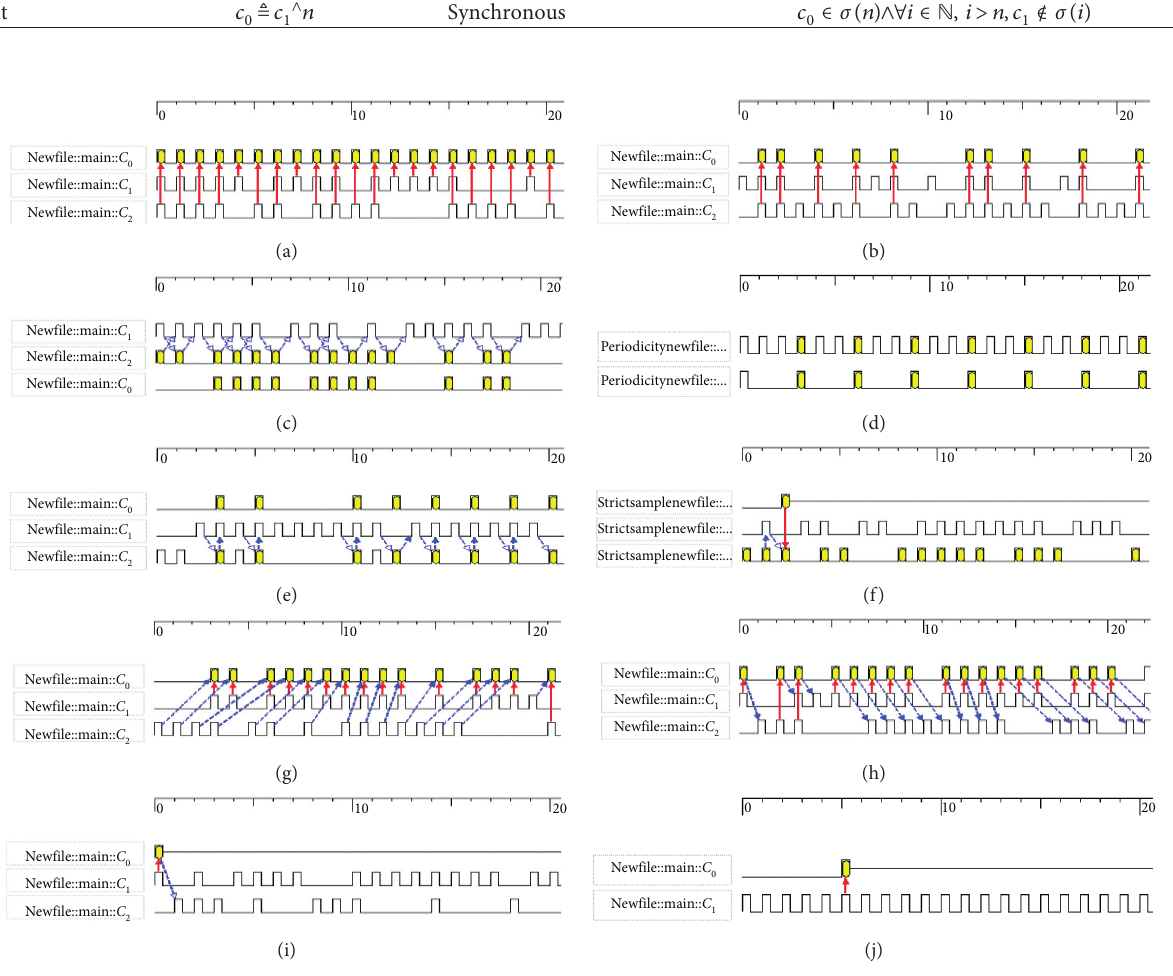
Figure 6: A possible schedule of base clock expressions: (a) c c ≜ c ▶ c , (g) c 0 1 2